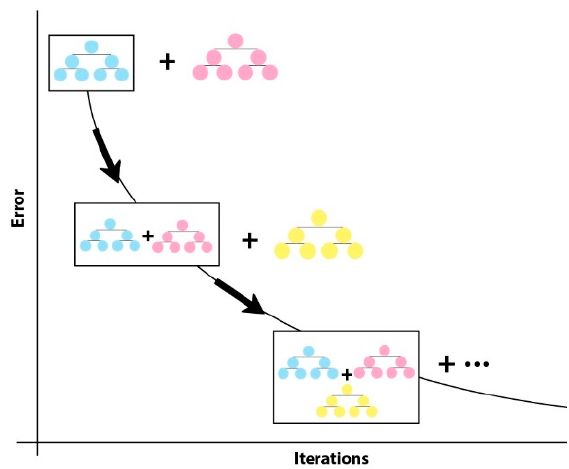
Figure 4. Gradient Boosted Tree Iterations.